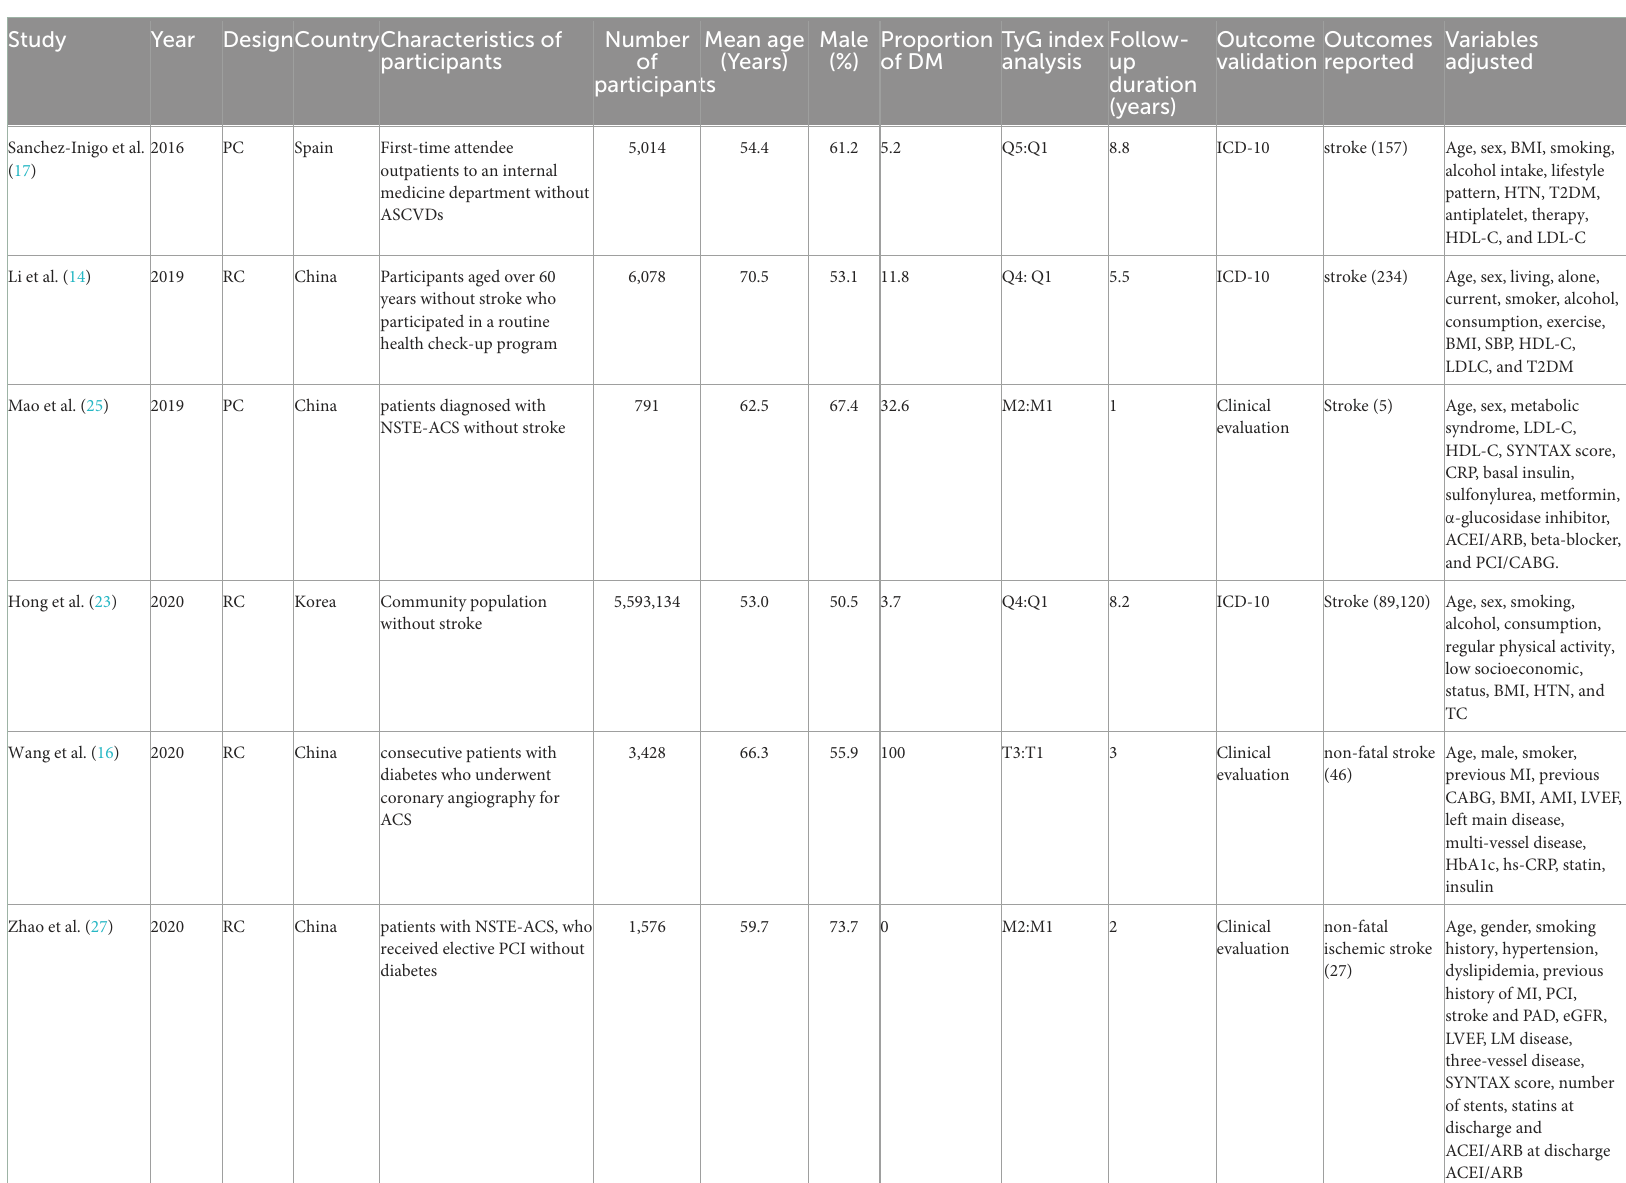
TABLE 1 Characteristics of the included cohort